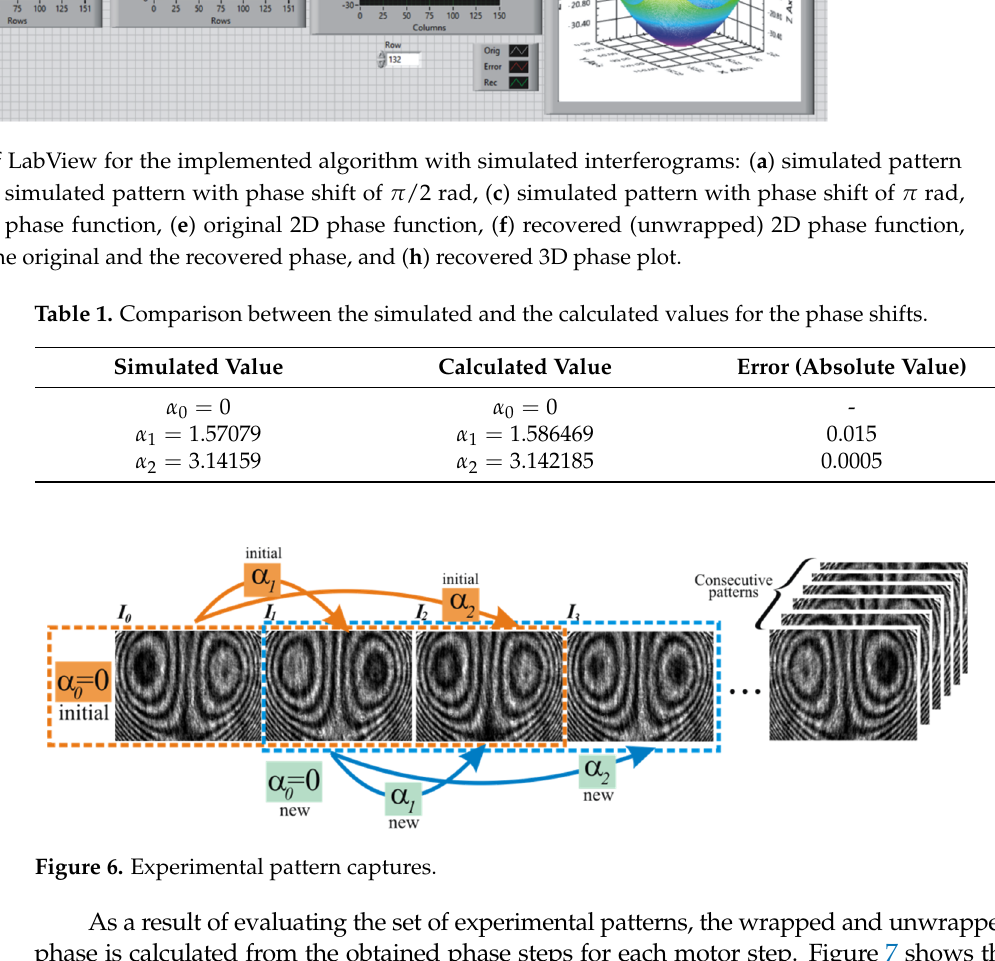
Figure 5. Front panel of LabView for the implemented algorithm with simulated interferograms: ( a ) simulated pattern without phase shift, ( b ) simulated pattern with phase shift of (cid:2024) 2⁄ rad, ( c ) simu- lated pattern with phase shift of (cid:2024) rad, ( d ) calculated wrapped phase function, ( e ) original 2D phase function, ( f ) recovered (unwrapped) 2D phase function, ( g ) difference between the original and the recovered phase, and ( h ) recovered 3D phase plot. Table 1. Comparison between the simulated and the calculated values for the phase shifts.